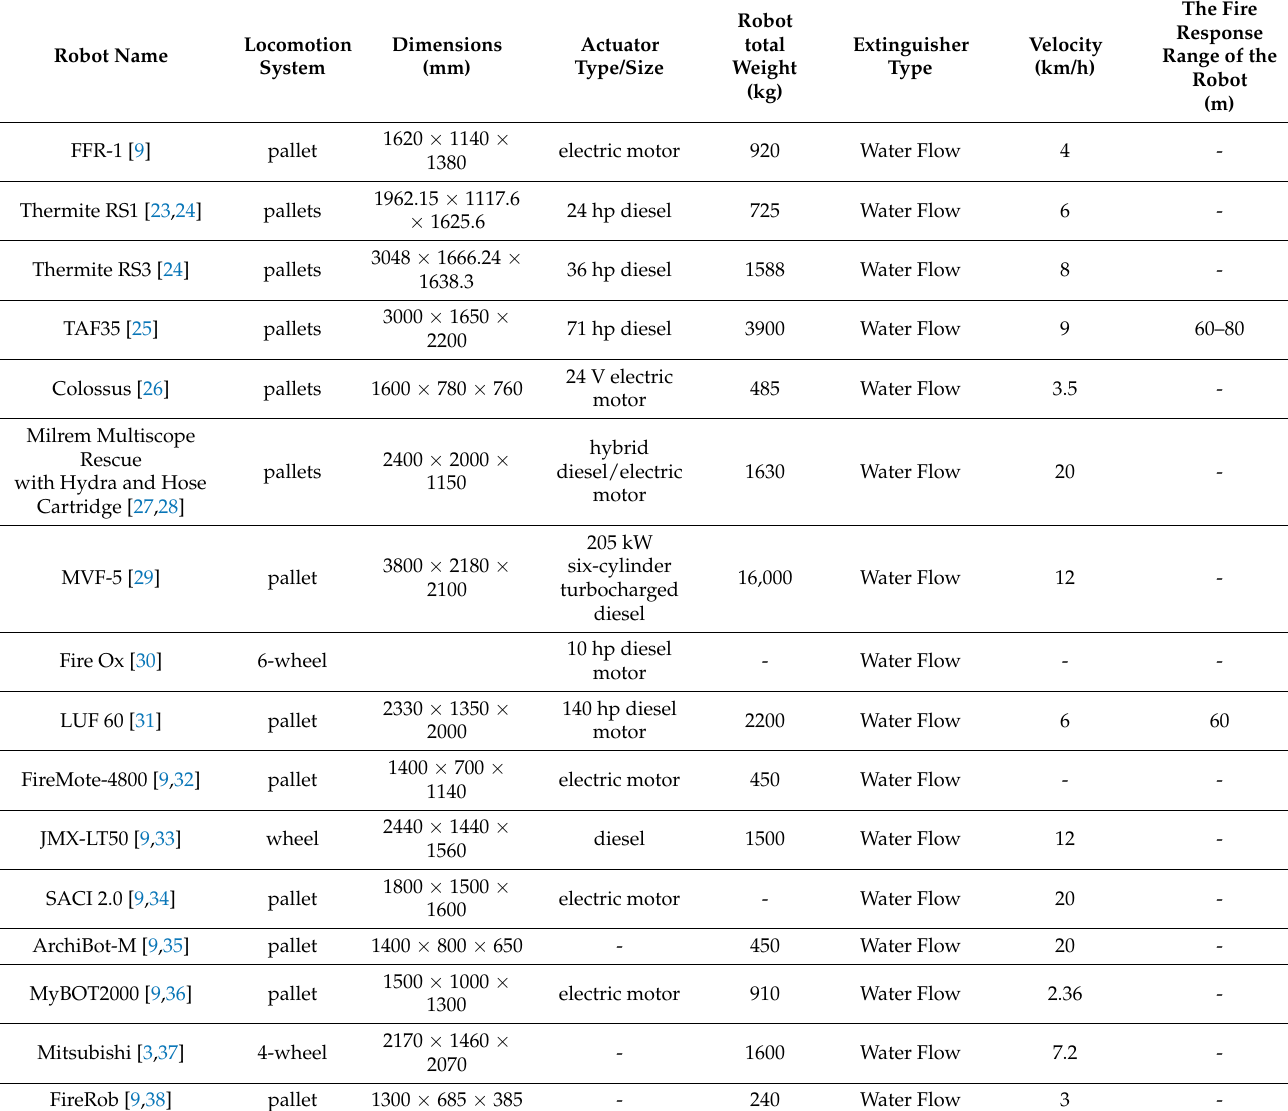
Table 1. Summarized important features of firefighting